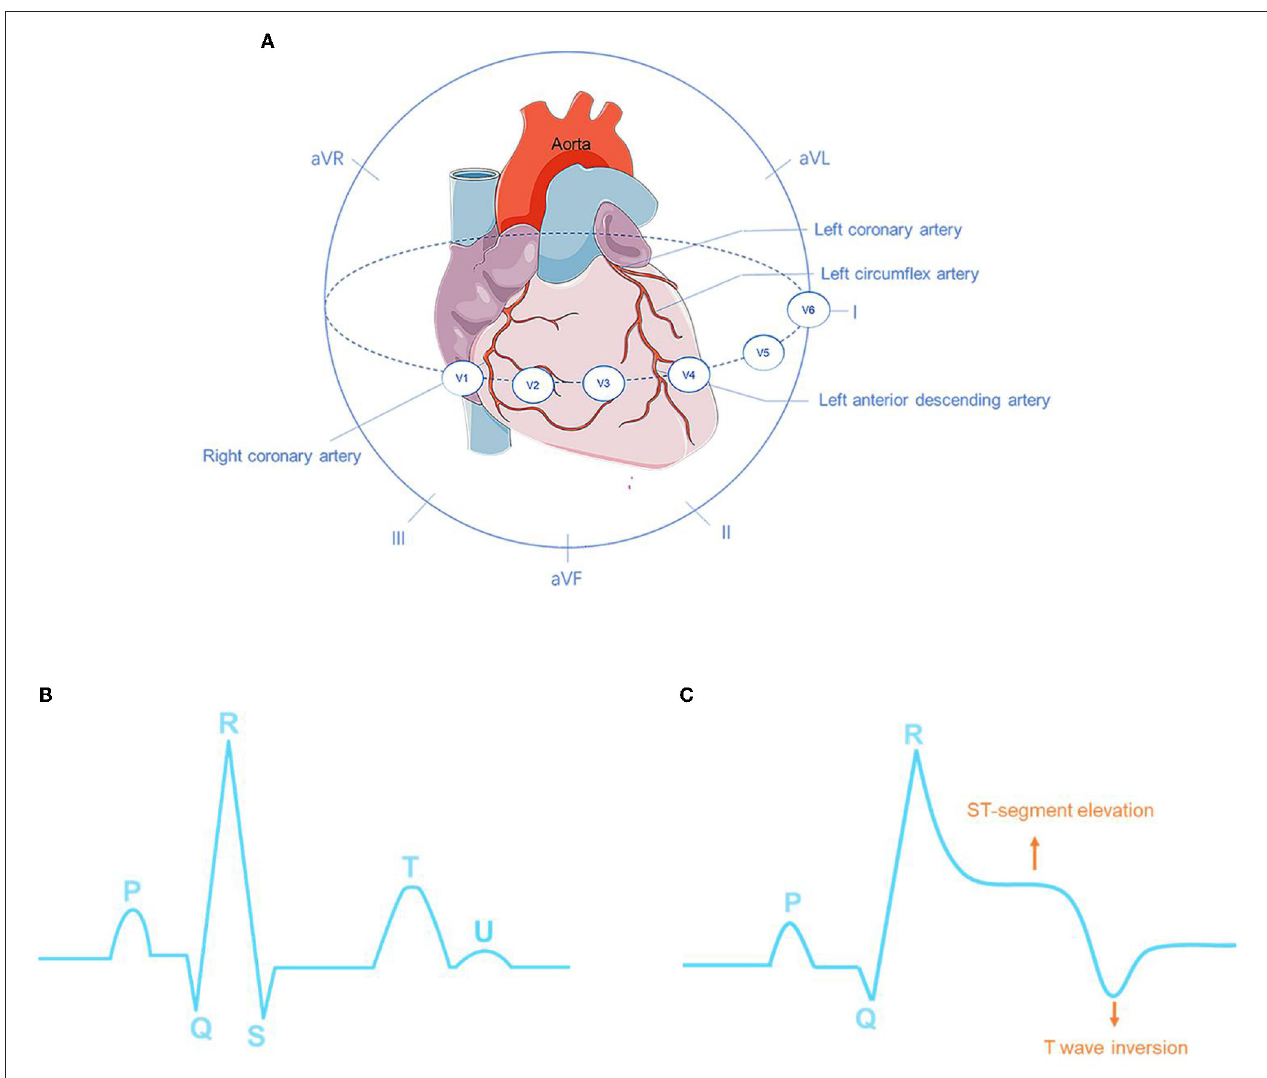
FIGURE 1 | Overview of coronary arteries structure and ECG 12 leads (A) . The ECG characteristics of normal sinus rhythm (B) and myocardial infarction (MI) (C) .